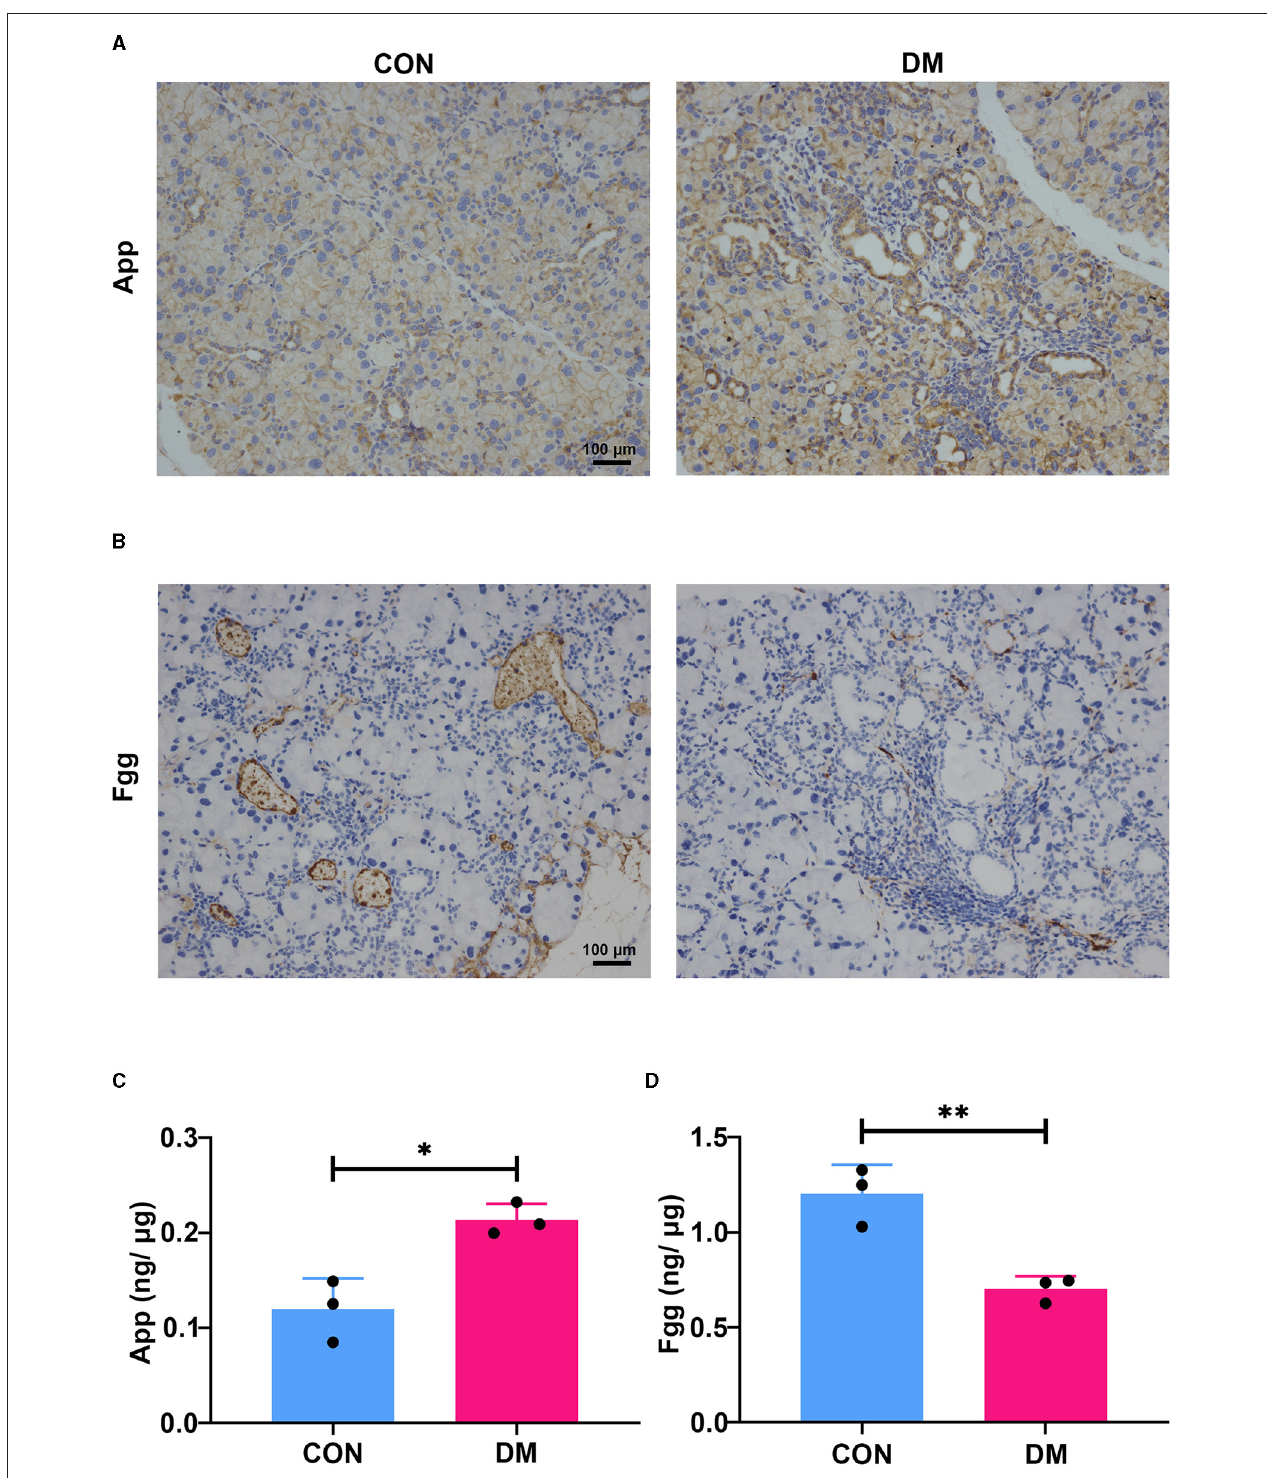
FIGURE 7 | Expression of App and Fgg in diabetic lacrimal glands. (A) The representative images of immunochemistry staining for App in T2DM and vehicle LGs at 6-month diabetic period. The App was mainly expressed at ducts, vessels, and acini. The diabetes group showed obvious expression aggravation. Scale bar: 100 µ m. (B) The representative images of immunochemistry staining for Fgg in T2DM and vehicle LGs at a 6-month diabetic period. Fgg was expressed in vessels and concentrated at a vascular endothelium. The diabetes group showed obvious expression reduction. Scale bar: 100 µ m. (C) The protein level of App in diabetic and age-matched vehicle LGs by ELISA ( N = 3/group). (D) The protein level of Fgg in diabetic and age-matched vehicle LGs by ELISA ( N = 3/group). (A–D) , data are representative of three independent experiments ( n = 3/group). C&D, Data were presented as the mean ± SEM. * P < 0.05, ** P < 0.01. T2DM, type 2 diabetes; LG, lacrimal